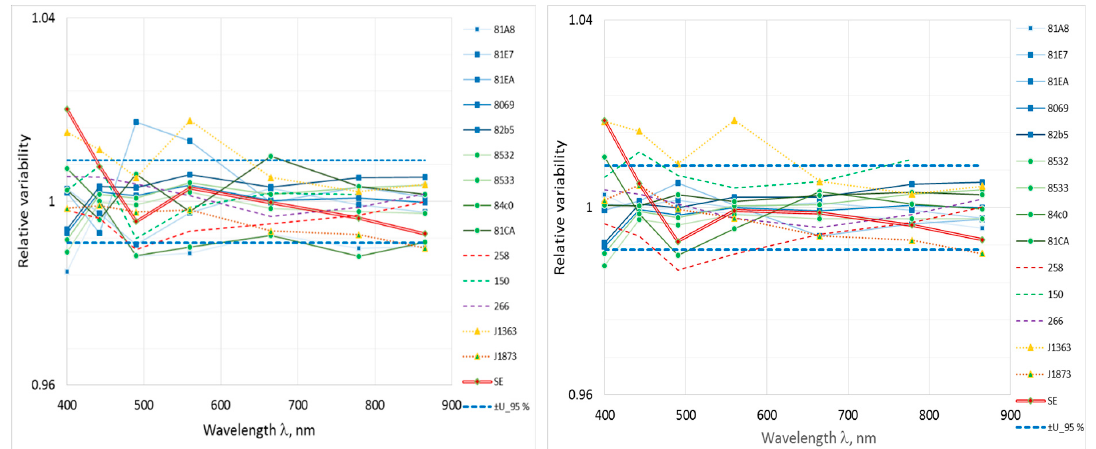
Figure 7. Irradiance sensors; agreement just after receiving data from participants (left), and after reviewing data by pilot, corrections submitted by participants and/or unified data handling by pilot (right).